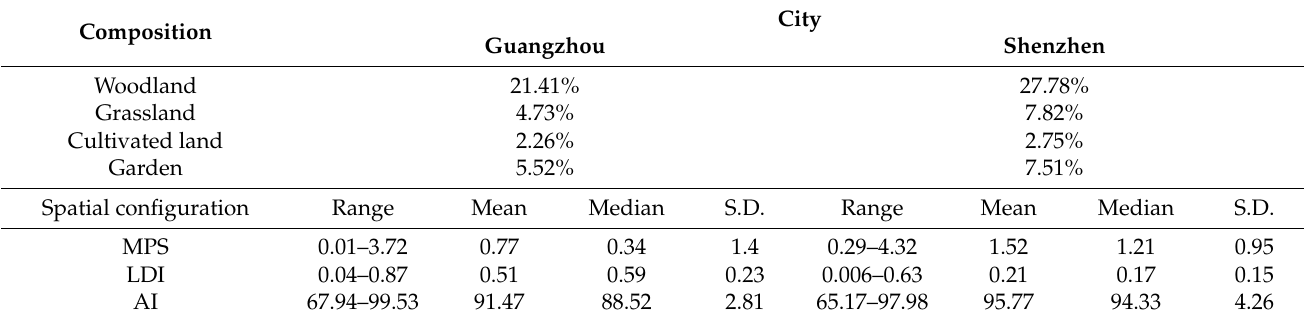
Table 4. Spatial pattern of UGI in Guangzhou and Shenzhen.